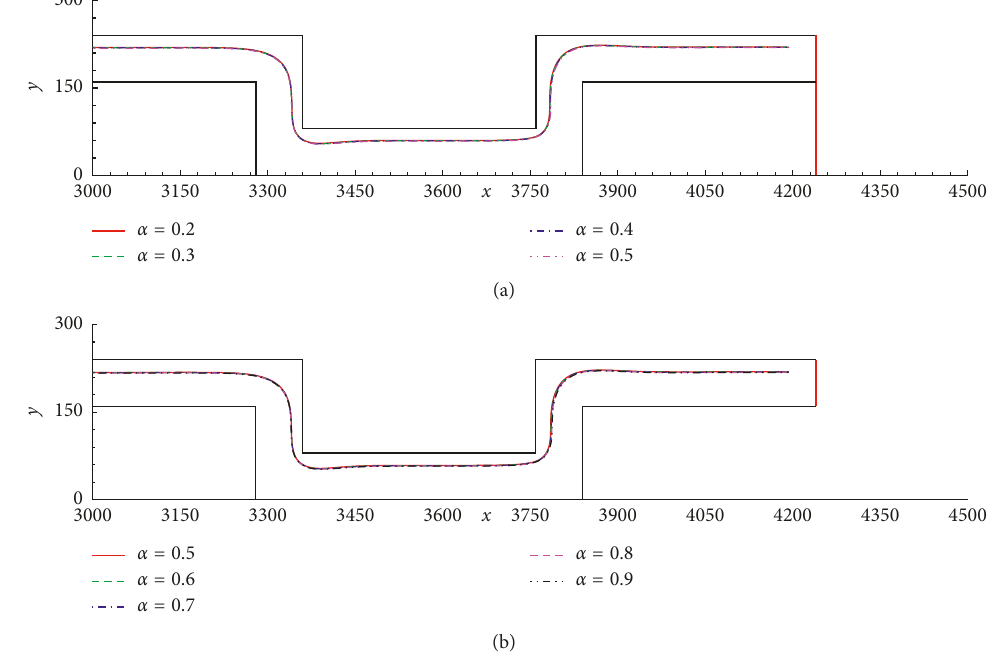
Figure 9: Particle trajectories for different density ratios when α